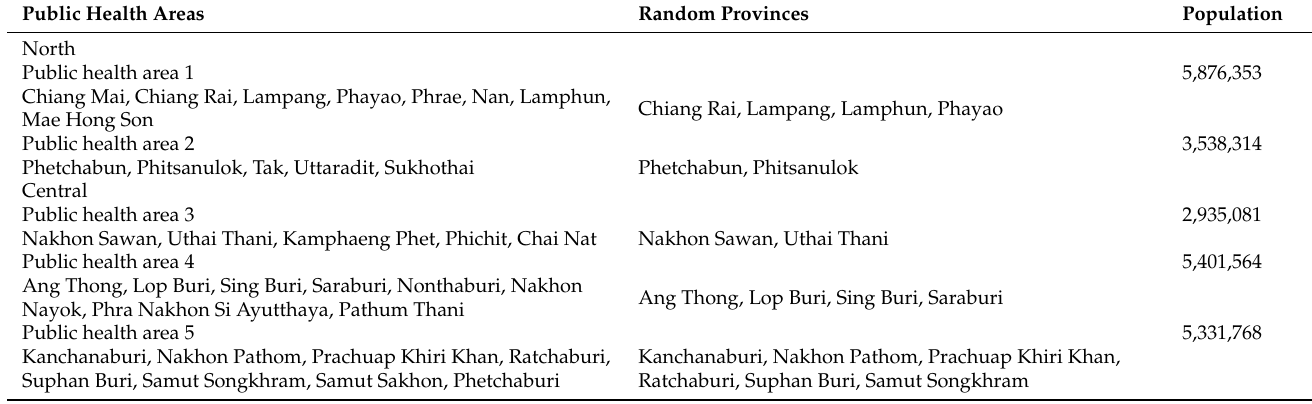
Table A1. Random provinces in